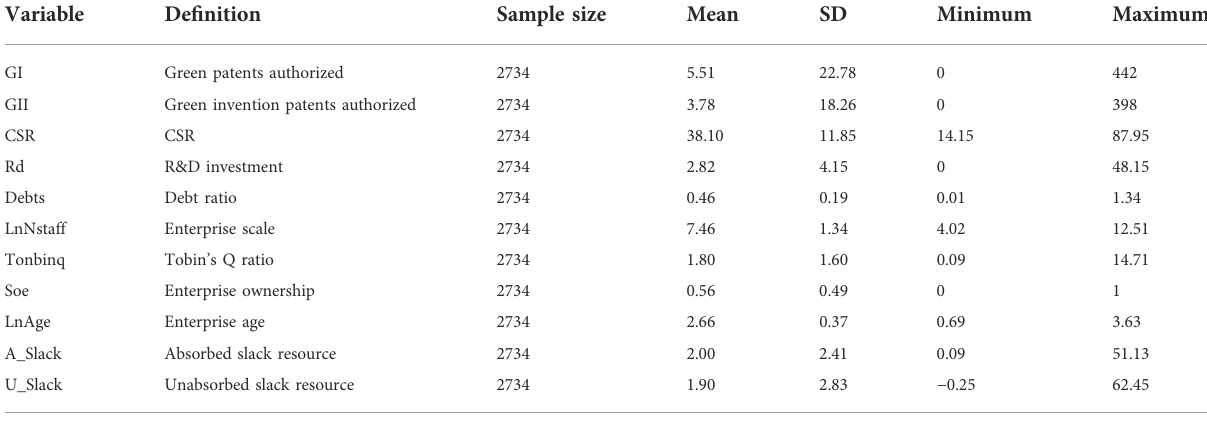
TABLE 2 Descriptive statistics.